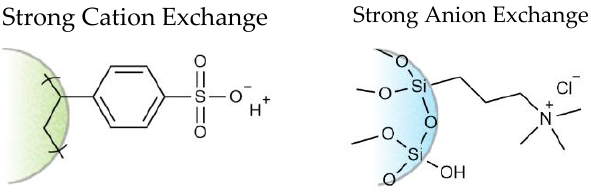
Figure 3. Sorbent chemistries of the Phenomenex STRATA ® X-C (left) and STRATA ® -SAX (right).